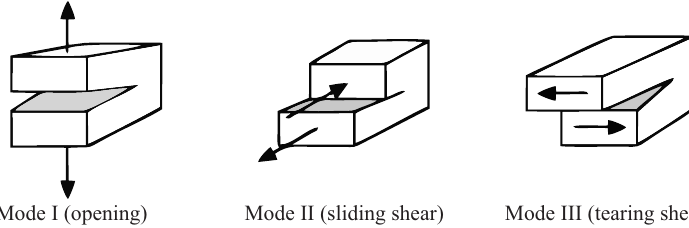
Figure 3. Fracture modes: Mode I with tensile delamination ( left ), Mode II with sliding shear delamination (centre), and mode III with tearing shear delamination ( right